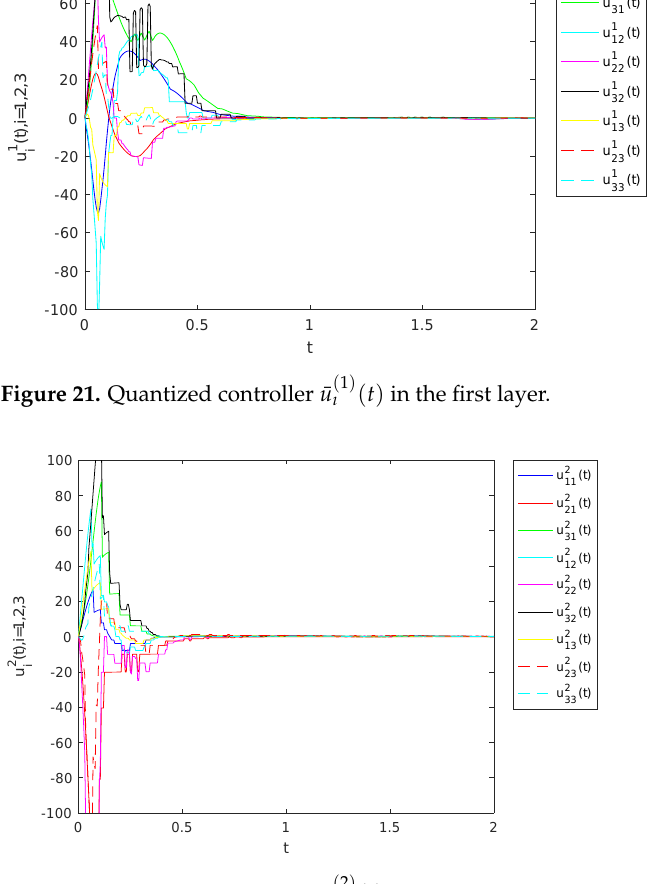
Figure 22. Quantized controller ¯ u